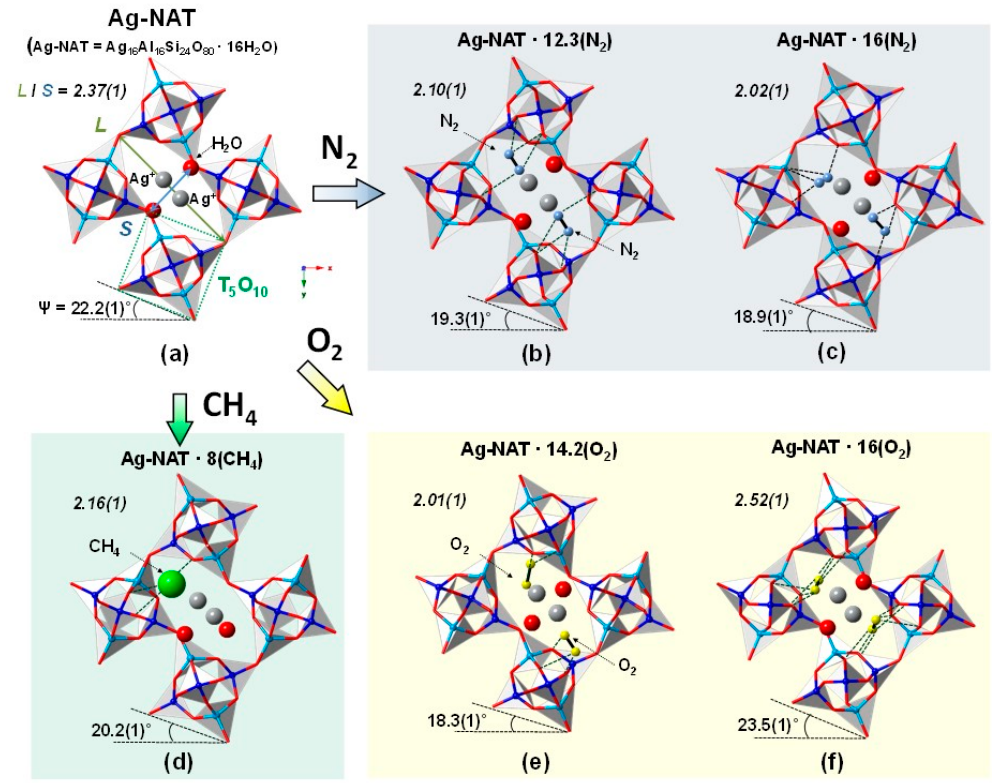
Figure 3. Polyhedral representations of ( a ) Ag-NAT and ( b ) Ag-NAT in N 2 at 1.44(5) GPa, ( c ) Ag-NAT in N 2 at 2.74(5) GPa, ( d ) Ag-NAT in CH 4 at 2.62(5) GPa, ( e ) Ag-NAT in O 2 at 2.51(5) GPa, ( f ) Ag-NAT in O 2 at 8.12(5) GPa. Blue balls in tetrahedra illustrate ordered distributions of Al (Si) atoms in the framework. Yellow, dark blue and green balls represent O 2 , N 2 and CH 4 , respectively. Dashed lines inside channel represent coordinate bonds of gas molecule and framework oxygen.